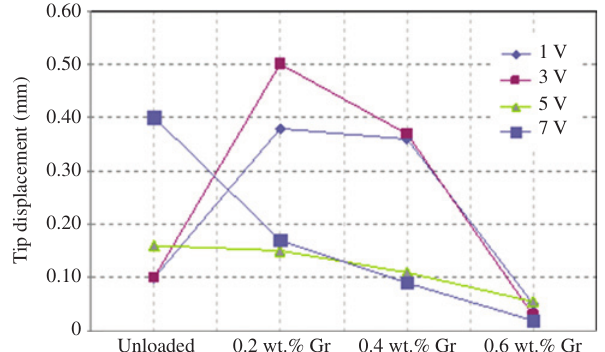
Figure 7: Maximum tip displacement of gold coated actuators with different Gr loading (1 mm in